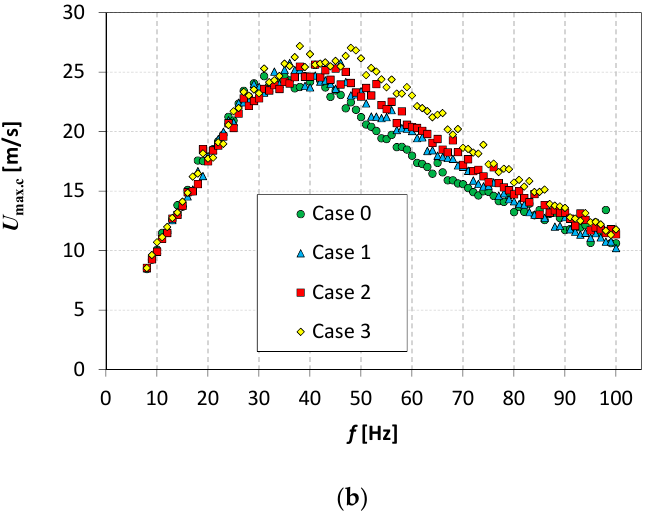
Figure 4. The local centerline time-averaged velocity ( a ) and local centerline maximum velocity ( b ) as a function of frequency at x / d = 0 and real power p = 3 W.